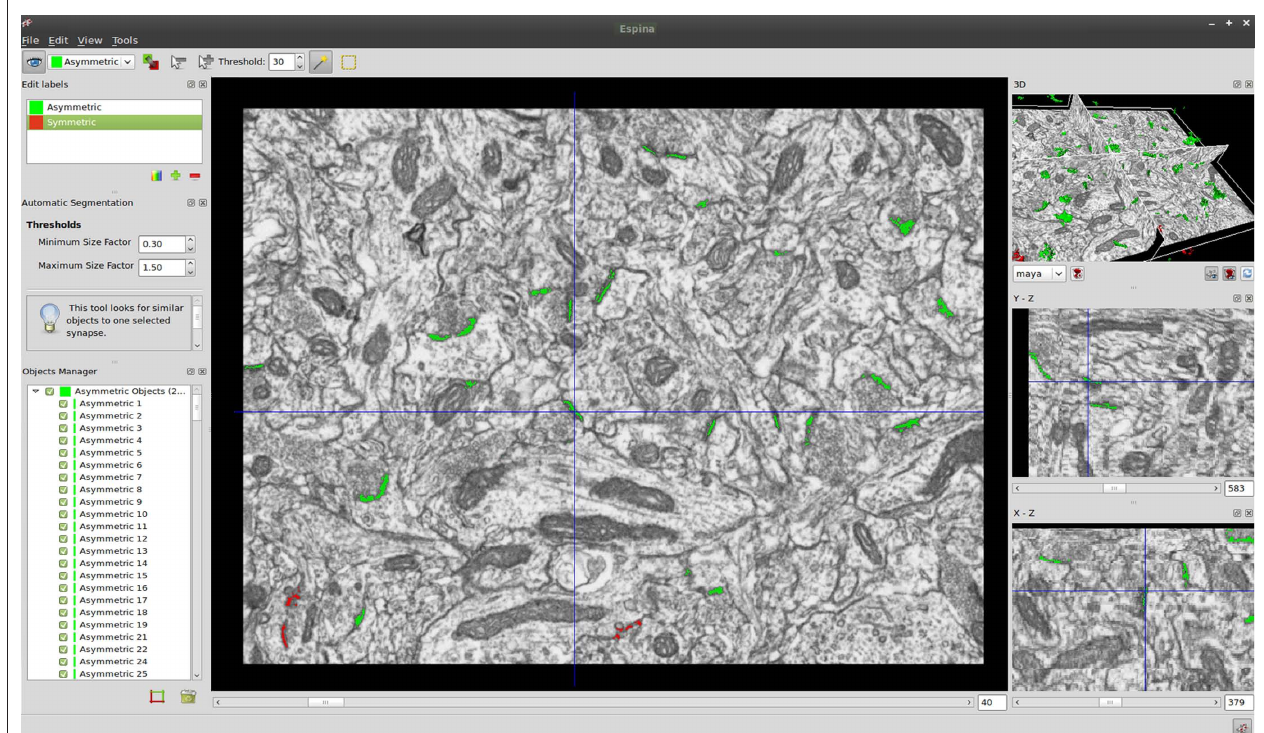
marked by crosshairs in all the windows. Segmented objects appear in green or red according to the colors selected by the user. Each segmented object is given a unique name and number, and it is listed in the “Objects manager” window. Although numerous synaptic junctions are apparently split into two or more parts, these parts are connected in other sections of the series (see also Video 1 in Supplementary